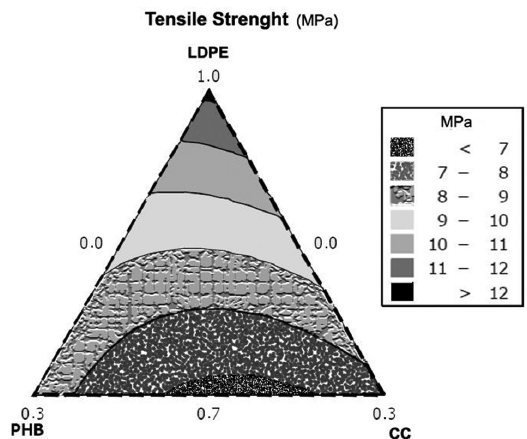
Figure 3. Response surface plot of tensile